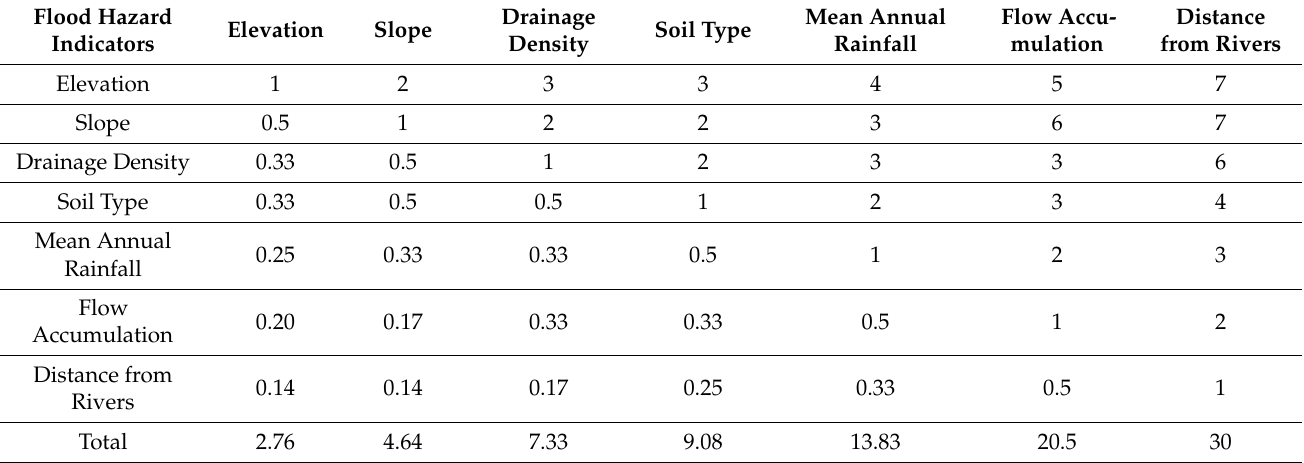
Table 3. Comparison matrix for flood hazard